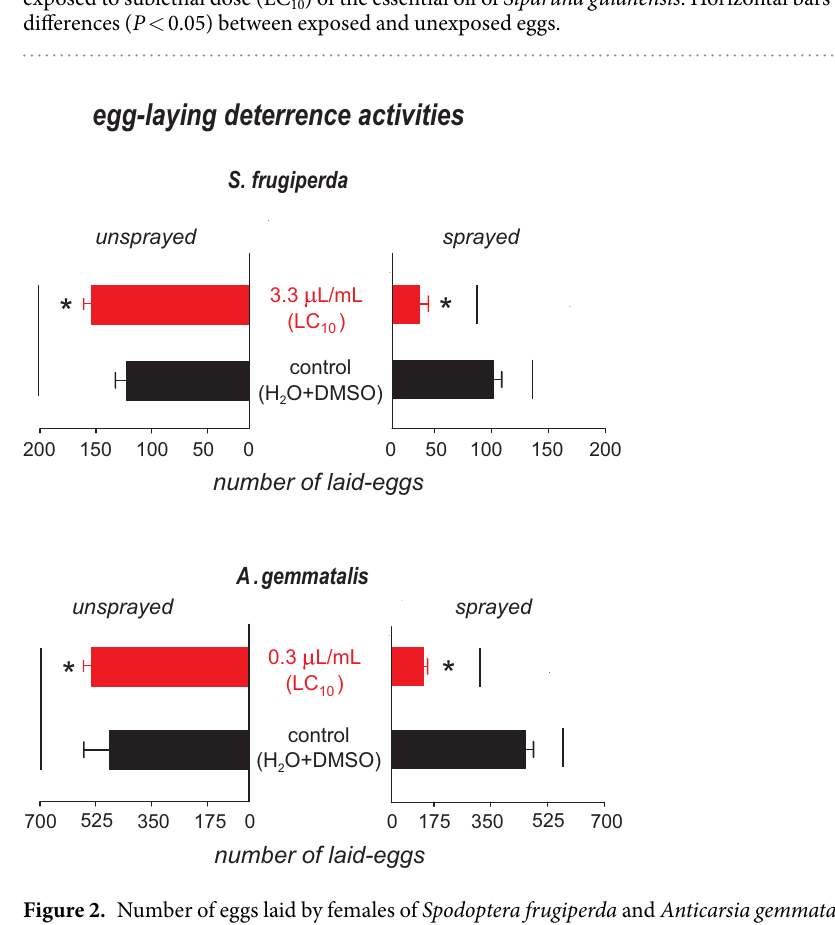
Figure 2. Number of eggs laid by females of Spodoptera frugiperda and Anticarsia gemmatalis on the sprayed with sublethal dose of the essential oil of Siparuna guianensis (LC 10 ) and the unsprayed (H2O + DMSO) sides of the oviposition containers. Asterisks indicate significant differences ( P < 0.05) between sprayed and unsprayed sides of the same treatment. Horizontal bars indicate significant differences ( P < 0.05) between the same sides of the essential oil of Siparuna guianensis and